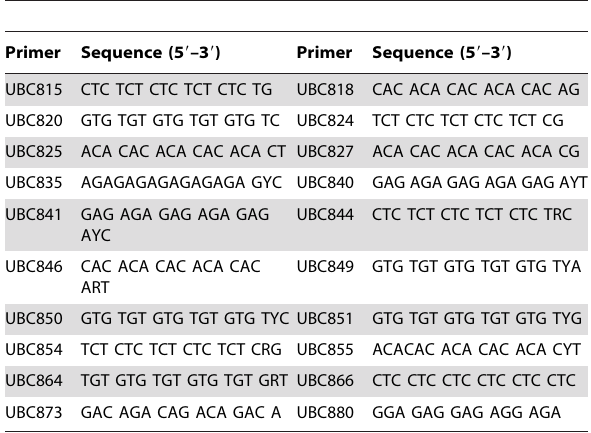
Table 1. Primers used in ISSR analyses of Alsophila spinulosa (R = A, G; Y = C, T).